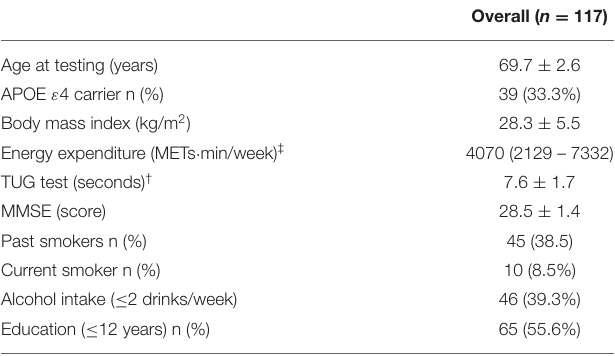
TABLE 1 | Participant